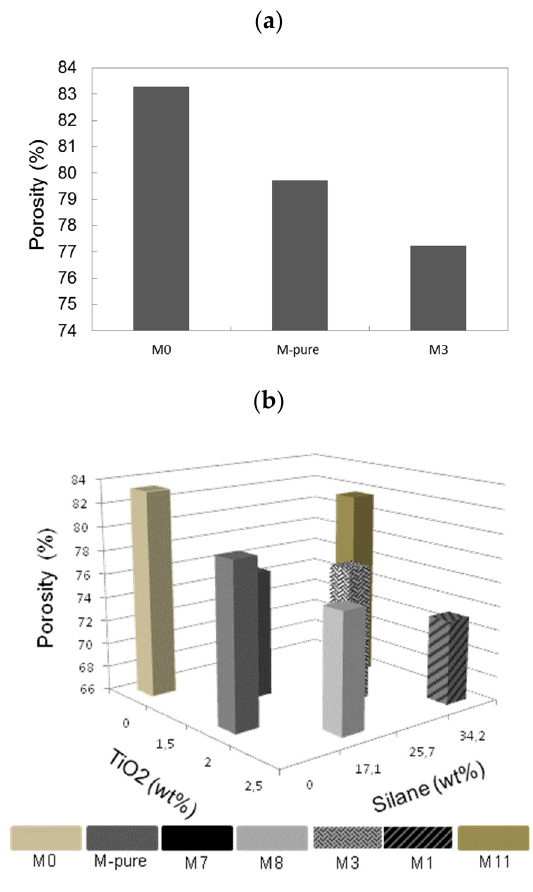
Figure 2. ( a ) The effect of TiO 2 concentrationon membrane porosity and ( b ) combined effect of TiO 2 and silane dosage on membrane